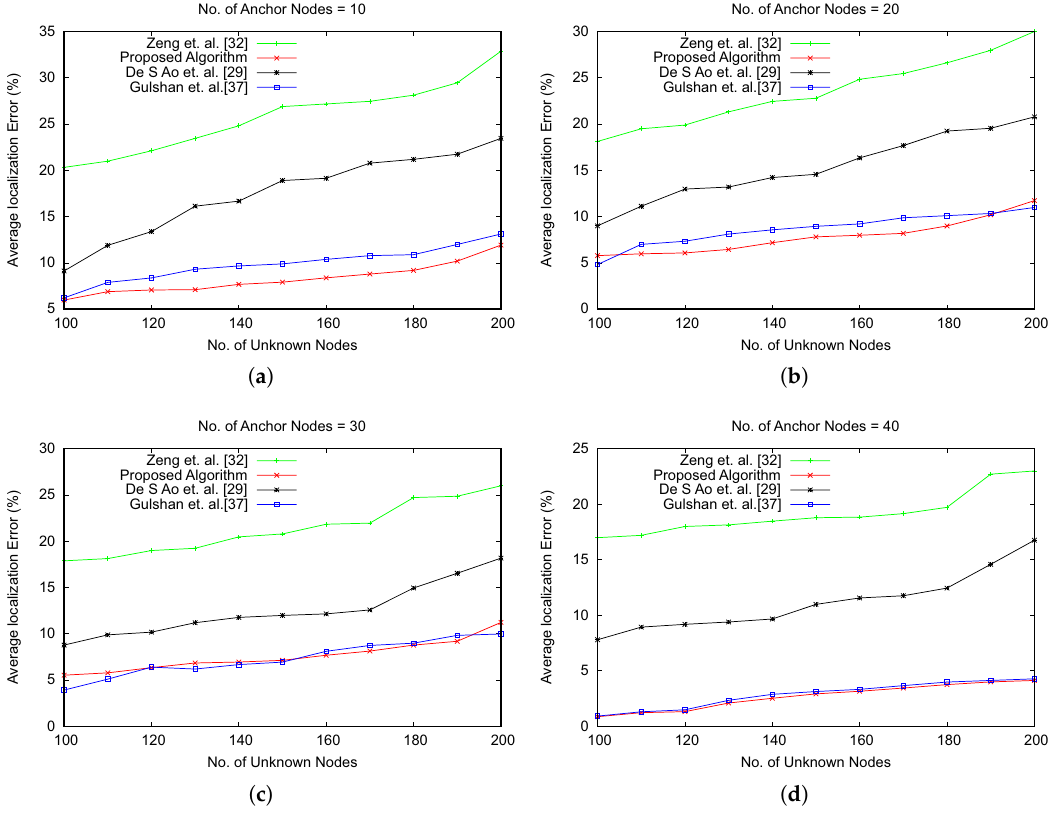
Figure 10. Average localization error